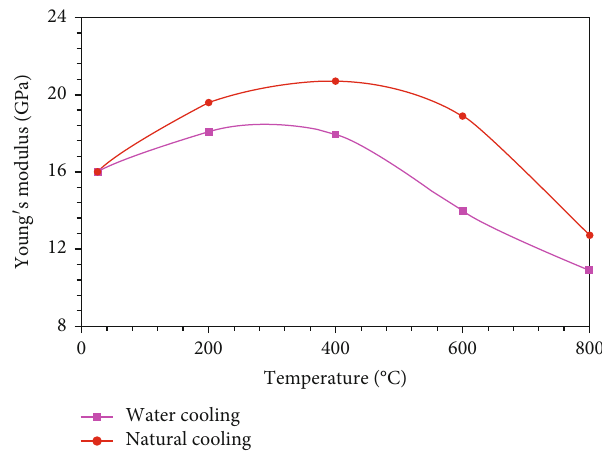
Figure 8: The variations of peak stress of core samples with temperature under two di ff erent cooling